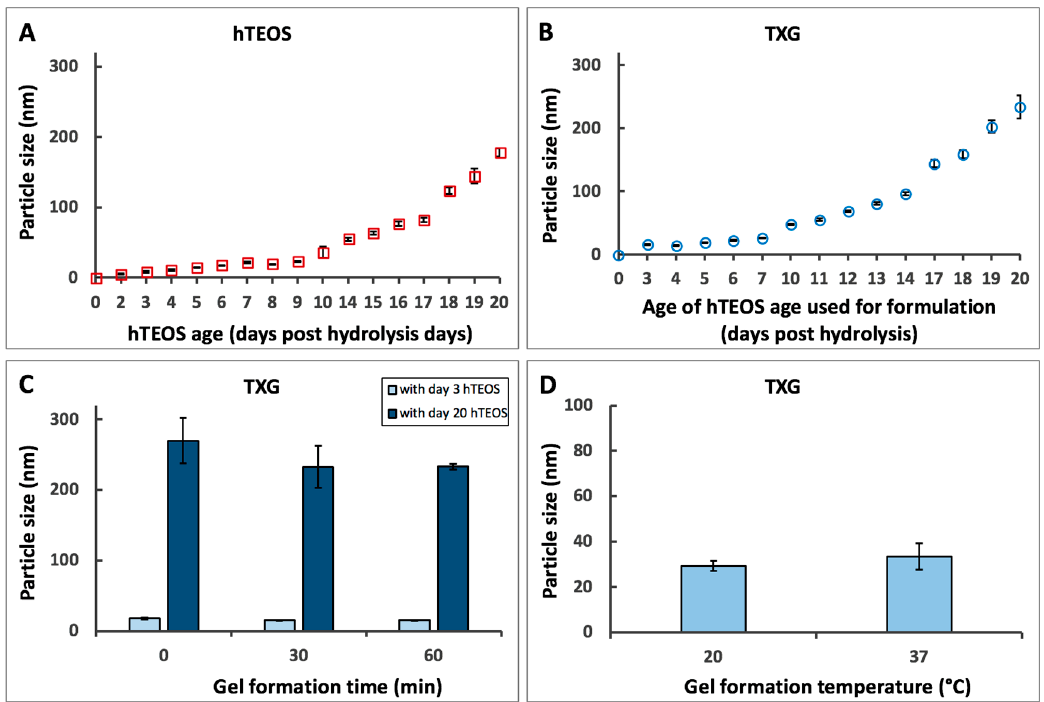
Figure 2. Hydrogel (TXG) formulation effects. ( A )—time-dependent particle size analysis of hydrolyzed TEOS (hTEOS); ( B )—particle size analysis of TXG formulated with different age hTEOS; ( C )—short time effects of hTEOS age on TXG particle size (ANOVA analysis for day 3 hTEOS indicated no statistically significant differences: p = 0.076 for alpha = 0.05, F = 4.086 and F crit = 5.143; ANOVA analysis for day 20 hTEOS indicated no statistically significant differences: p = 0.989 for alpha = 0.05, F = 0.011 and F crit = 4.786); ( D )—effects of TXG formation temperature on its particle size (no statistically significant differences, TTEST p = 0.3).